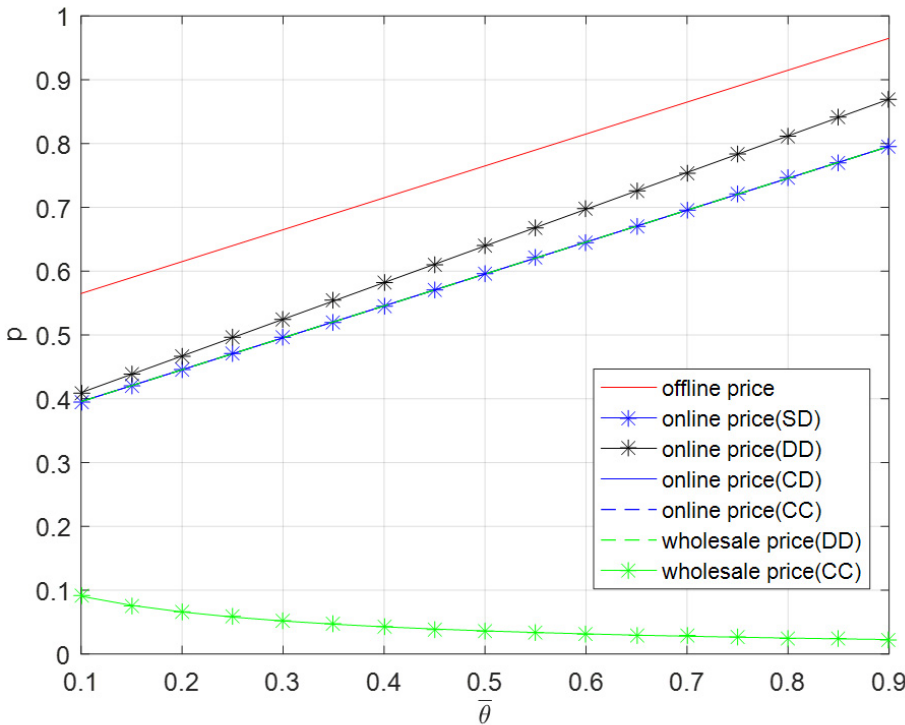
Figure 8. Optimal price versus θ